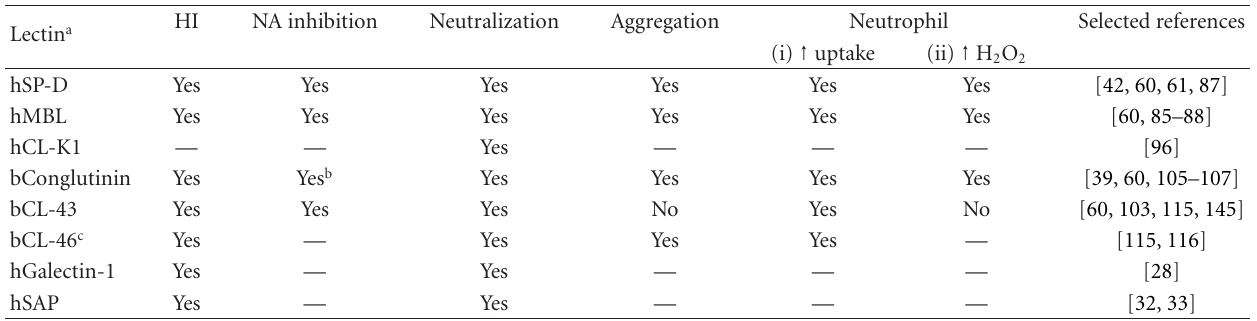
Table 2: Summary of antiviral activities mediated by animal lectins against